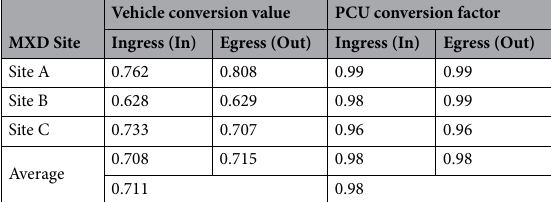
Table 3. VCV and PCU conversion factor for all MXD sites.